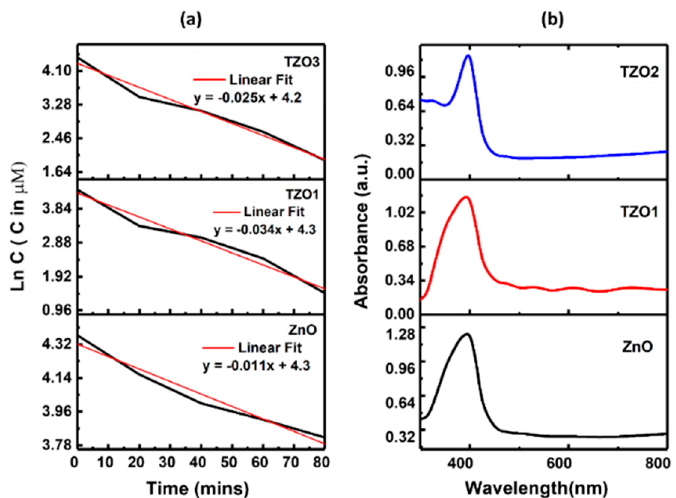
Figure 13. ( a ) Plot showing the linear regression curve fit for the natural logarithm of absorbance of the methylene blue concentration against irradiation time for ZnO, TZO1 and TZO2. ( b) Absorbance spectrum of ZnO, TZO1 and TZO2. Reproduced with permission from Ref. [32]; published by Springer Nature, 2018.